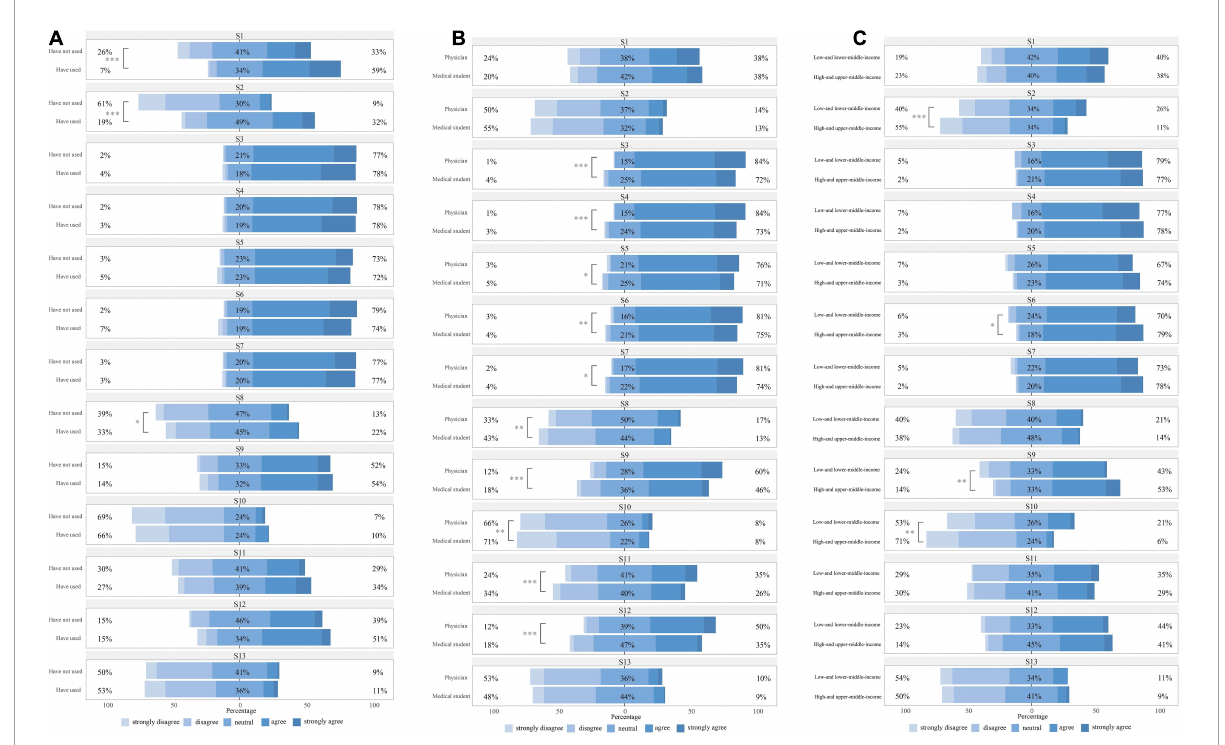
FIGURE5 Subgroup analysis of responses to 13 statements. (A) By clinical artificial intelligence (AI) use experience; (B) By identity; (C) By country specific income levels. Mann–Whitney U test, * p < 0.05, ** p < 0.01, *** p <